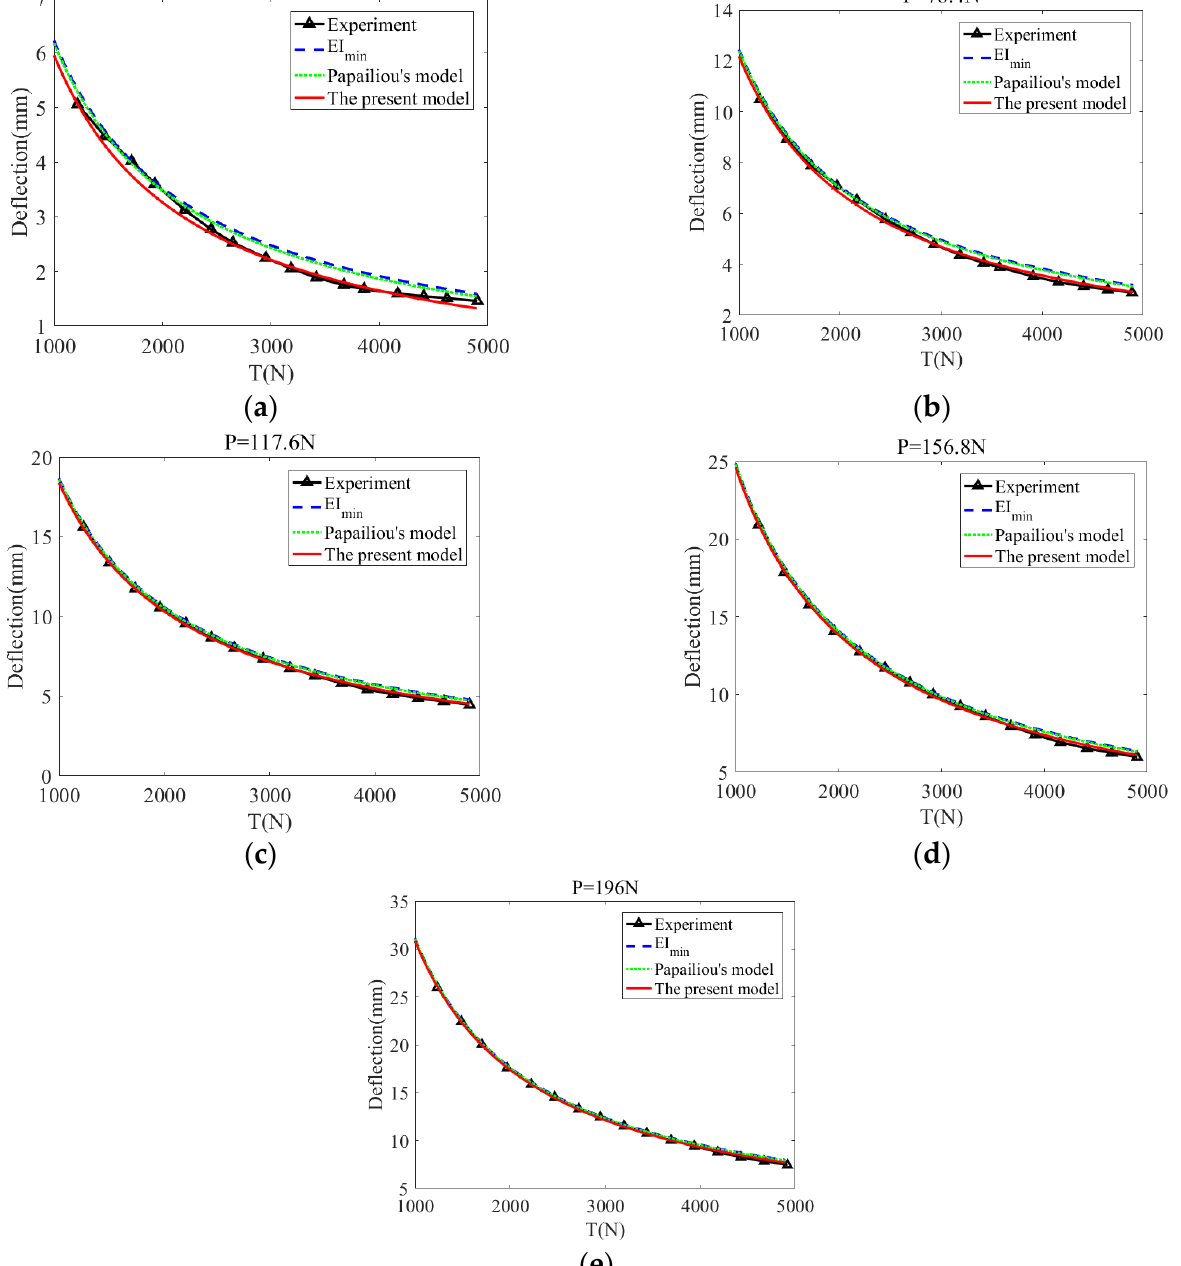
Figure 18. Comparisons of deflection obtained from the present model, the theoretical values corresponding to the minimum bending stiffness, the theoretical study of Papailiou and experimental measurements for simple strand subjected to a variable T ranging from 1 kN to 5 kN and a lateral concentrate force: ( a ) P = 39.2 N (4 kg); ( b ) P = 78.4 N (8 kg); ( c ) P = 117.6 N (12 kg); ( d ) P = 156.8 N (16 kg); ( e ) P = 196N (20